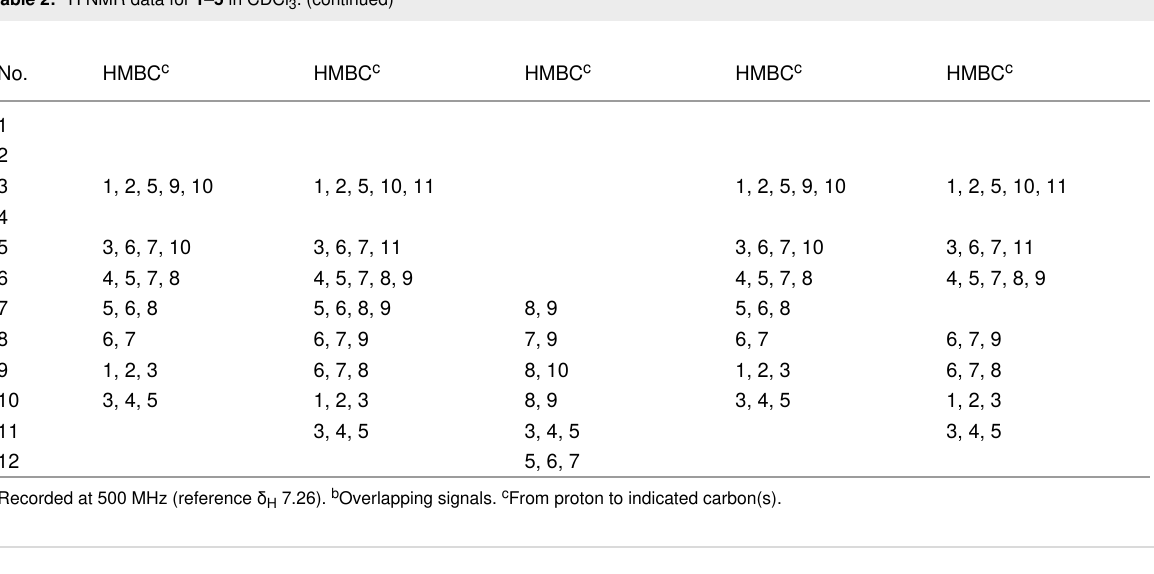
Table 2: 1 H NMR data for 1 – 5 in CDCl 3 . (continued)